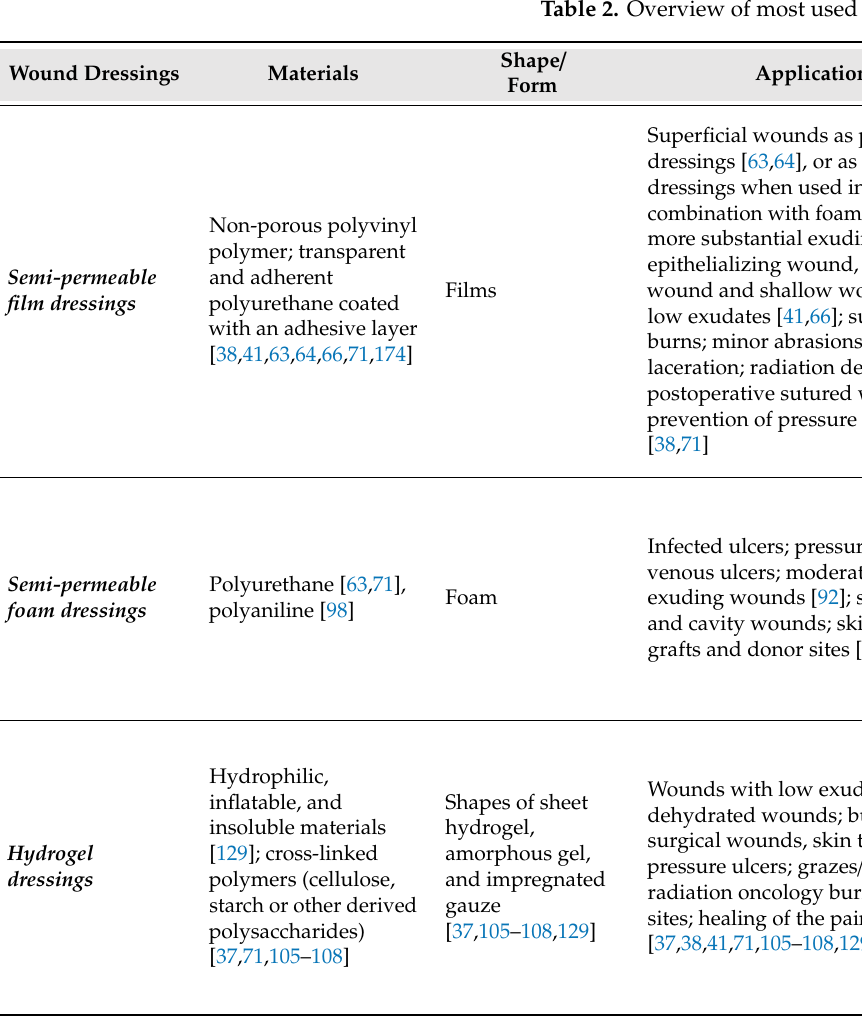
Table 2. Overview of most used advanced wound